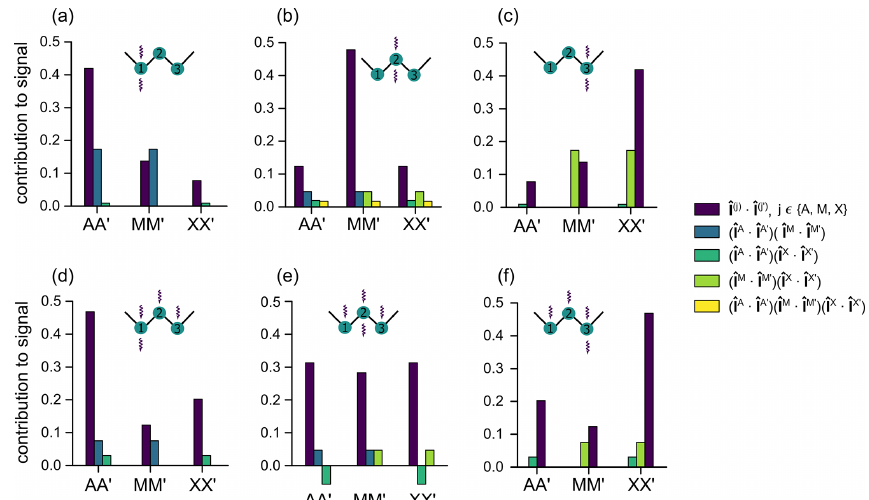
Figure 6. Calculated contributions of the seven different LLS terms ˆ P µ (the 3 two-spin terms are shown in the same color) in the density operator of Eq. (3) to the observed signals for all six different single and poly-SLIC experiments used in this work to determine the relaxivities r ( a ) in the six-spin systems of DSS (I) and homotaurine (II). The histograms show the products, λ M → LLS µ ˜ λ LLS → M µ , of the coefficients of LLS LLS excitation and reconversion methods. The normalization ensures that the sum of all products of coefficients is equal to 1. Experiments with triple SLIC excitation and single SLIC reconversion applied to the middle CH 2 group (e) provide LLSs that are almost evenly distributed among all three CH 2 groups, whereas the other experiments provide access to LLSs that are in part localized on the group where the reconversion SLIC pulse is applied. The excitation and reconversion of the (yellow) six-spin term is negligible except for case (b)